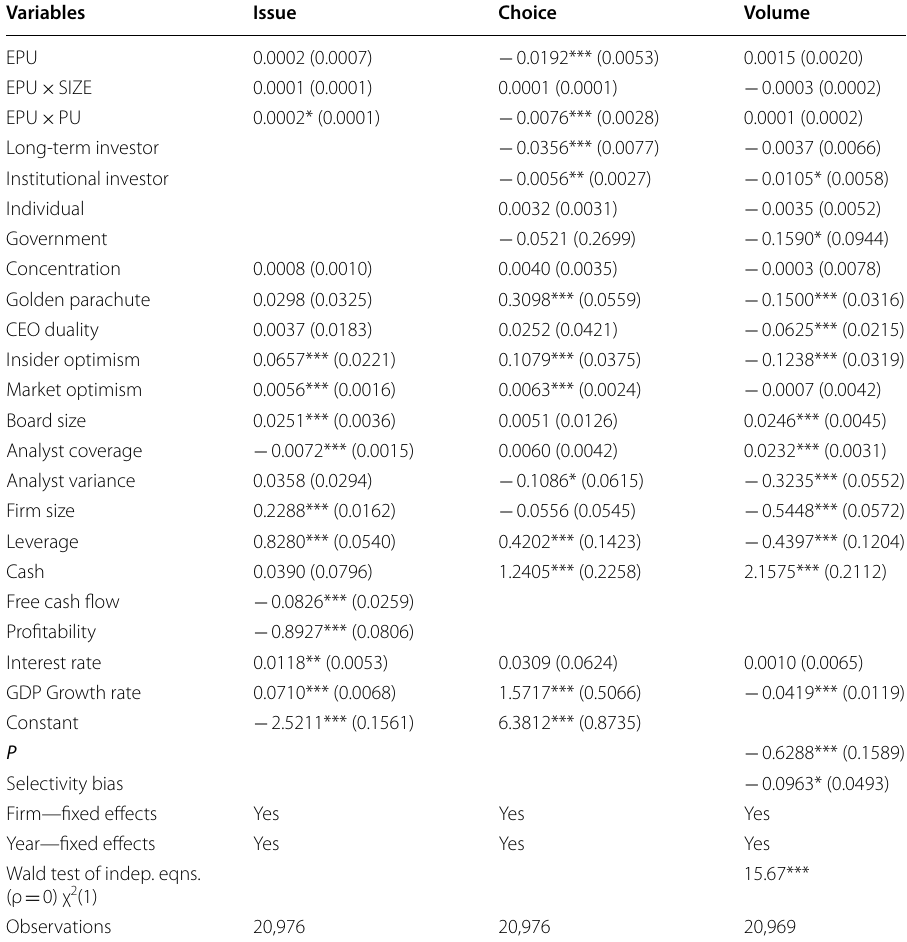
Table 6 Empirical estimations based on the Heckman three-stage ordered probit model with firm- fixed effects and year-fixed effects and robust standard